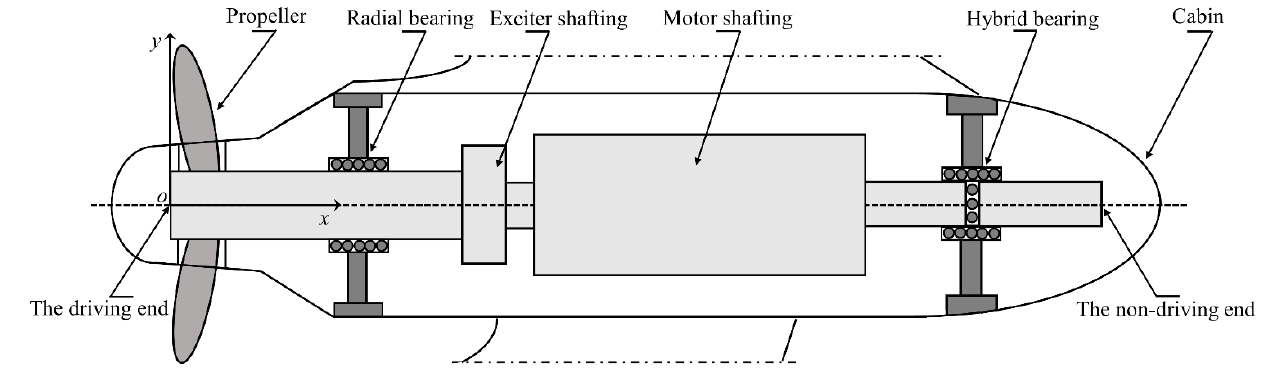
Figure 1. Schematic diagram of podded propulsor shafting